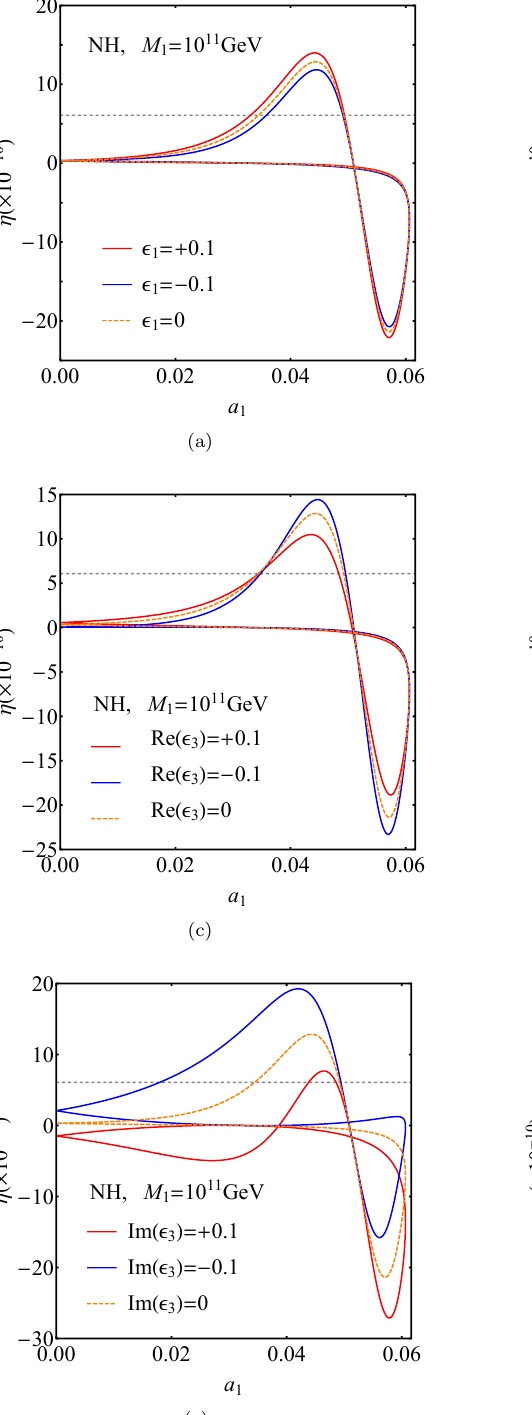
) arising from some example values of M and symmetry- 1 1 < 10 12 GeV. The gray dashed line stands 1